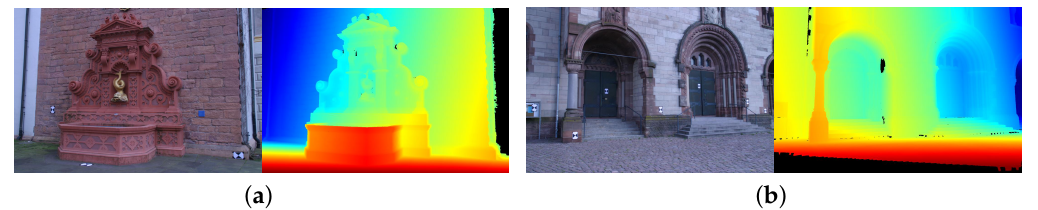
Figure 9. Sample color images and their ground truth depthmaps. ( a ) shows the images from Fountain-P11 and in ( b ) are samples from Herz-Jesu-P8 .